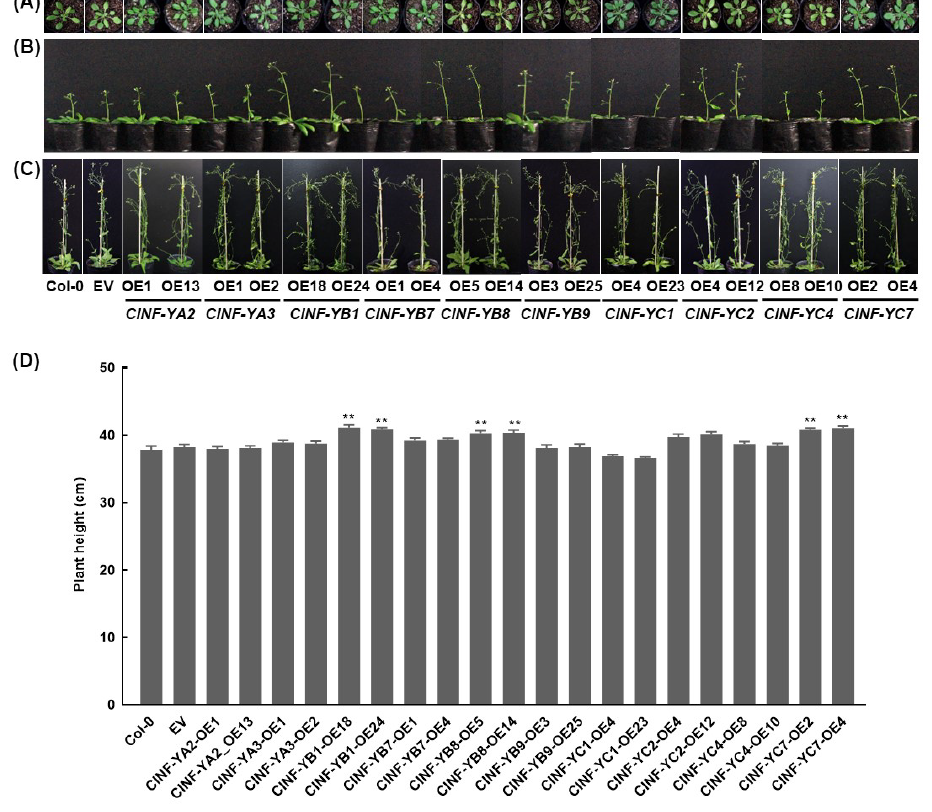
Figure 8. Growth and flowering phenotypes of the ClNF-Y -overexpressing plants. ( A-C ) Phenotypes of four-week-old plants before bolting ( A ), flowering ( B ), and six-week-old plants after bolting ( C ). ( D ) Plant heights of six-week-old plants. Experiments were performed three times with similar re- sults. Data presented in ( D ) are the means ± SD and ** above the columns indicate significant differ- ences at the p < 0.01 level.